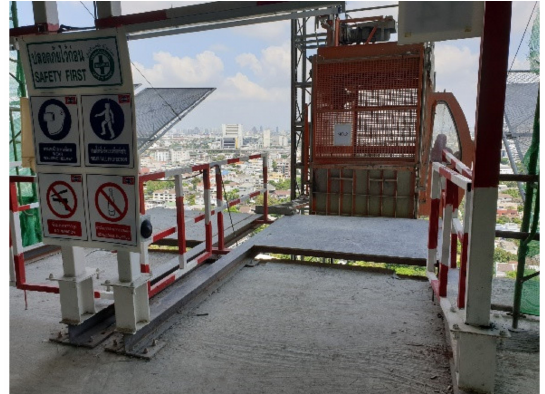
Figure 4. Landing platforms for hoist lift.